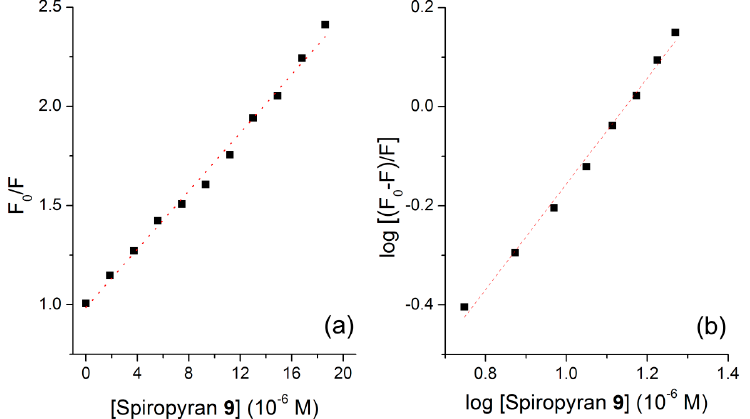
Figure 7. Stern–Volmer equation plots of BSA fluorescence intensity vs. spiropyran concentration in the suppression experiment ( a ) and log-log plot of BSA fluorescence intensity vs. spiropyran concentration ( b ) used to obtain the binding constant (K a ) and binding sites (n) from Equation (5).